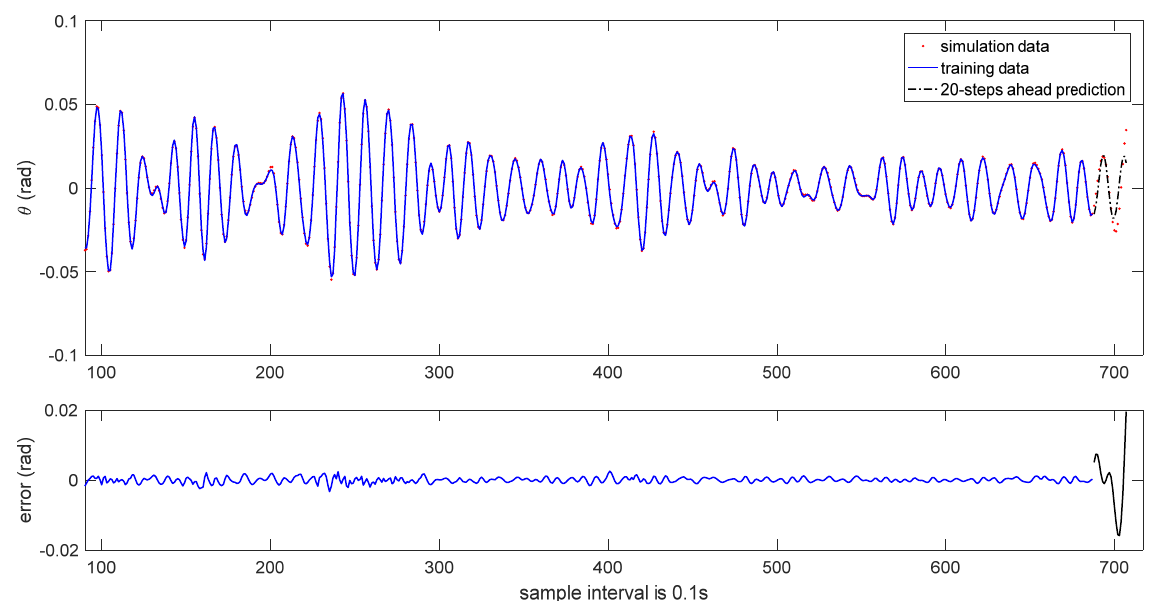
Figure 11. The 20-steps-ahead prediction of pitch motion in irregular waves at the instant k = 687 for the R-Class Icebreaker model.